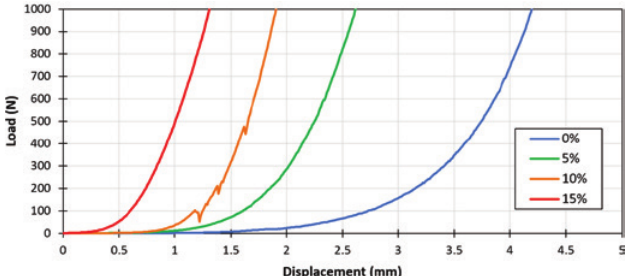
Figure 8 Rheological behavior of the cementitious matrixes with various ratios of GD added, evaluated by the squeeze-flow